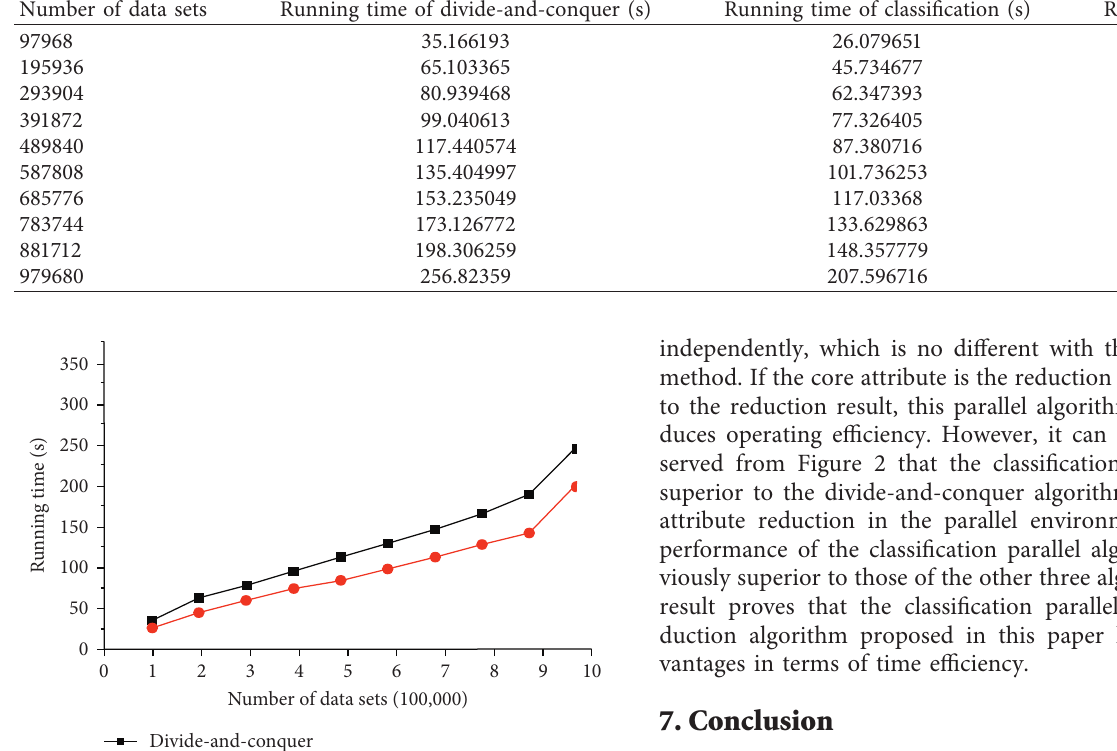
Table 2: Attribute reduction results of the two algorithms in parallel testing. Number of data sets